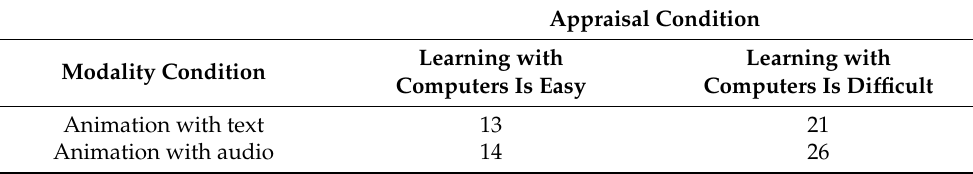
Table 3. Descriptive data of experiment 2.